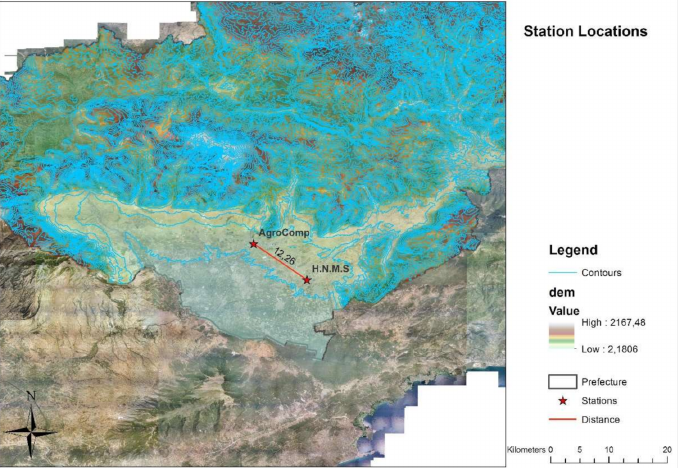
Figure 6. Location of the two weather stations (Basemap from Greek National